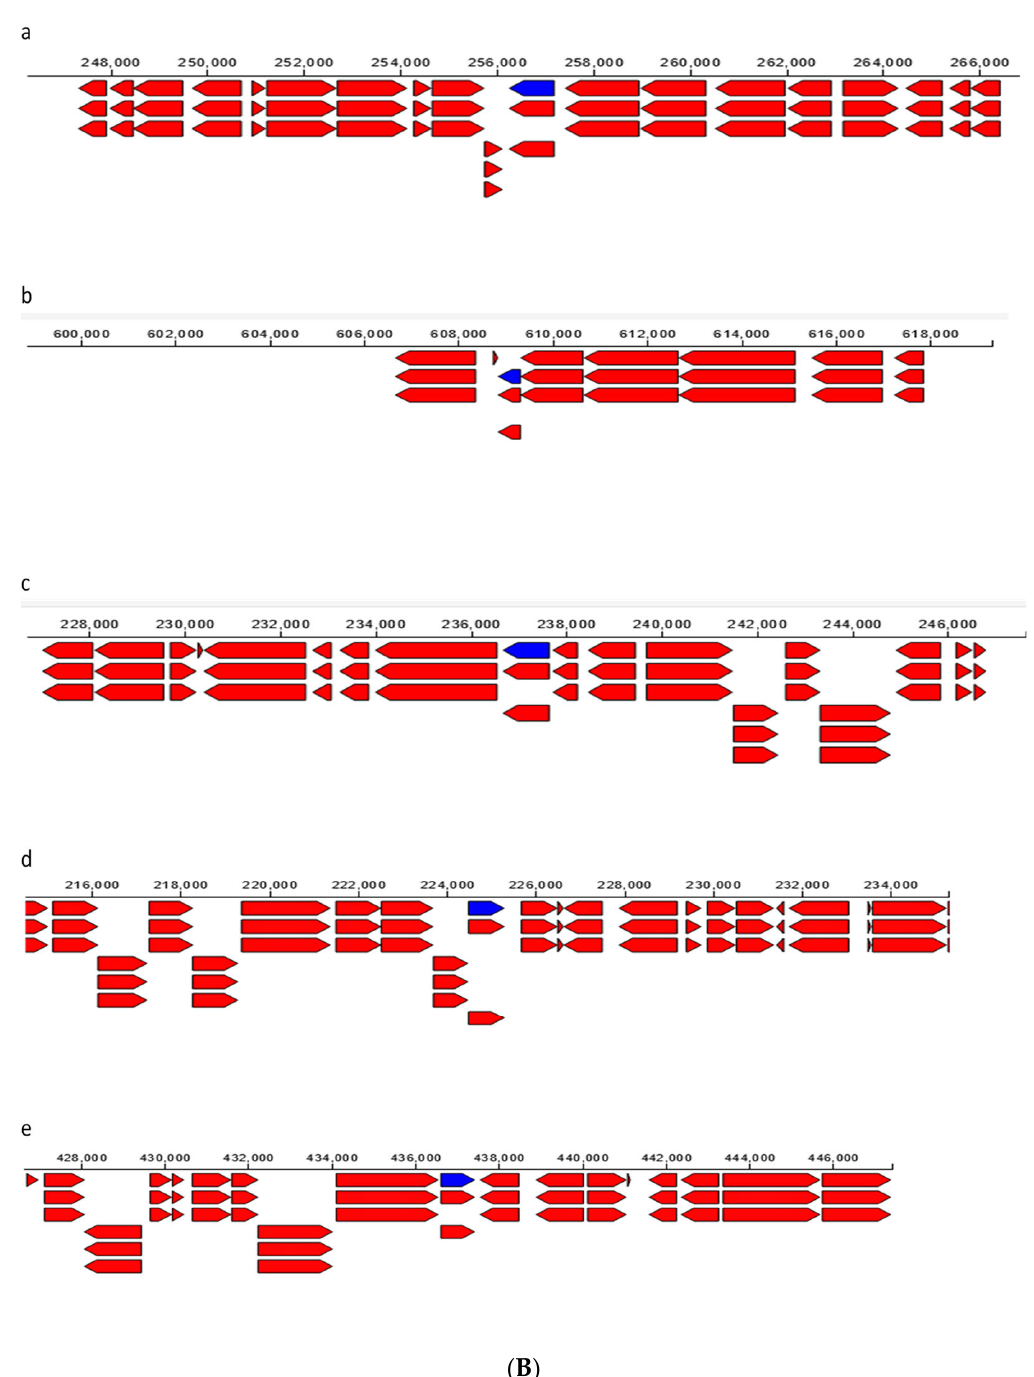
Figure 4. ( A ) Annotation of plant probiotic-influencing genes and their location in the genome of endophytic Stenotrophomonas geniculata strain NWUBe21 (a). Acid phosphatase gene (b). Alkaline phosphatase gene (c). Ammonia/Ammonium transporter gene (d). Exopolyphosphatase gene (e). Ferribacilibactin gene. ( B ) Annotation of plant probiotic-influencing genes and their location in the genome of endophytic Pseudomonas carnis NWUBe30 (a). Auxin efflux carrier protein gene (b). Biofilm PGA auxillary protein gene (c). Iron sideropohore protein gene (d). Nitrogen-fixing nifU gene (e). Pyrroloquinoline quinone (Coenzyme PQQ) biosynthesis protein gene.